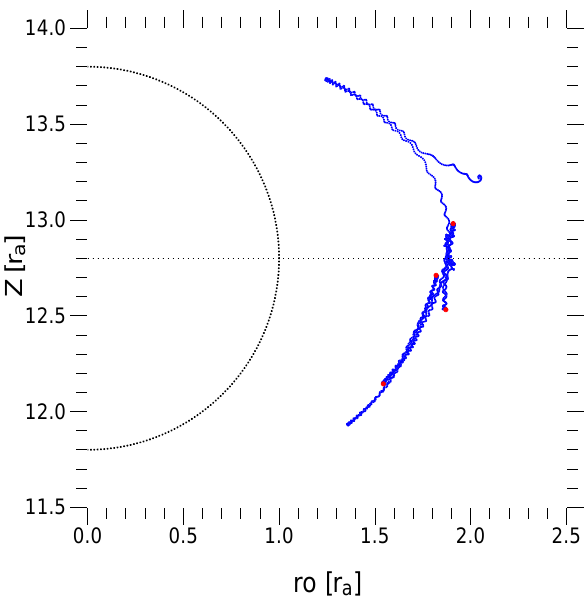
Fig. 5b. Time profiles of the dusk-electron energy (in red), and the fields it encounters, electric (in green) and magnetic (in blue). Fig. 5a. Dusk-electron trajectory in ( z , ρ ) plane, where ρ is The curve C in blue situated below the profiles at − 0.03 level, is the p (x − x o ) 2 + (y − y o ) 2 . The moments the cylindrical radius, ρ = cosine of the angle between the two fields. The curve in black above t =2.352, 3.02, 3.953, 4.52s are marked in red. The surface of the the profiles is the z-coordinate of the electron position. Scales for object is represented by a circle. the two are on the